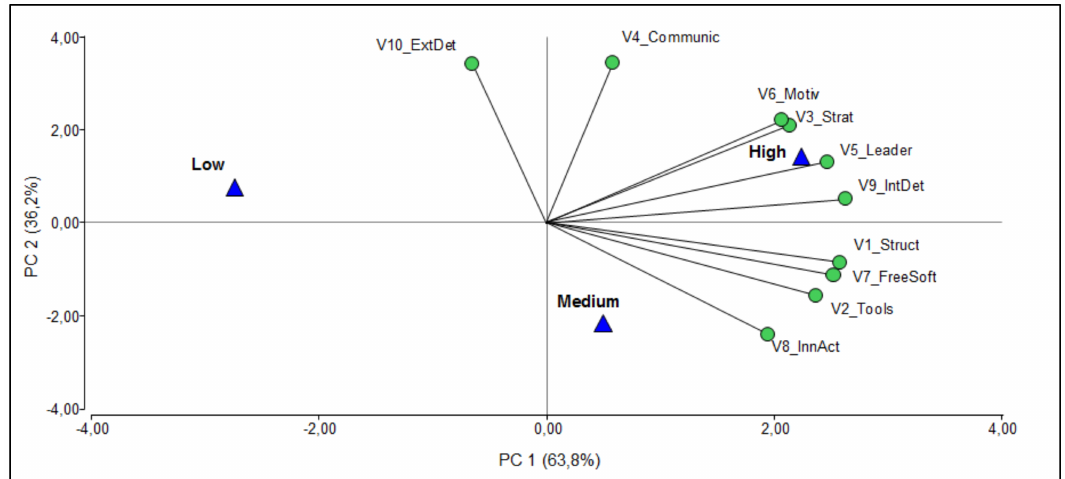
Figure 1. Biplot for the result groups and each of the capability variables.